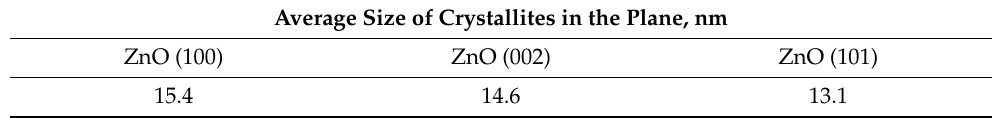
Table 1. Average size of ZnO crystallites in